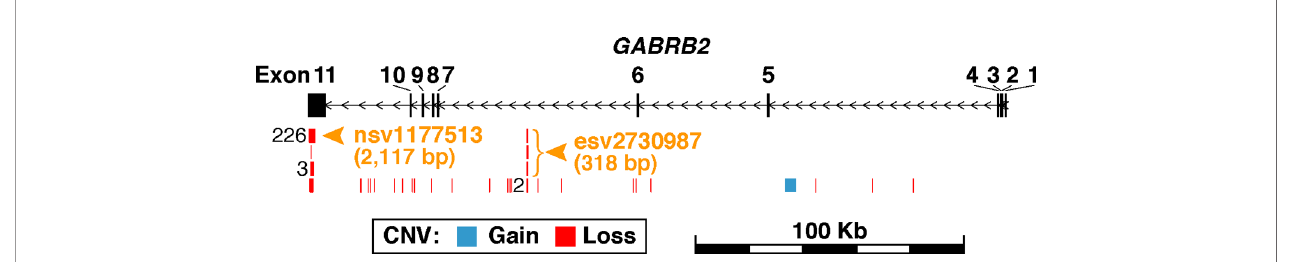
FIGURE 1 | Schematic representation of germline CNVs in GABRB2 . The region shown spans 20-Kb upstream and downstream of GABRB2 at chr5:160,715,436- 160,975,130. Exons are represented by the black vertical rectangles, and introns by horizontal line segments between the exons. Each exon is numbered above its corresponding rectangle. Black arrows indicate direction of transcription. CNVs retrieved from the database of human genomic structural variation (dbVar; fi le date 2018-03-04) are shown in blue for copy-number-gains and red for copy-number-losses. CNVs with identical genomic coordinates are merged as one in the fi gure, with their number of occurrences labeled left to their positions. A total of 261 CNVs falling within GABRB2 are mapped to 31 parental copy-number-regions in dbVar (see the full list of CNVs in Supplementary Table S1A and the summary statistics of their parental copy-number-regions in Supplementary Table S1B ). CNVs are found to be highly recurrent in Exon 11 and Intron 6, where the parental copy-number-regions with the most CNV occurrences were selected for investigation in the present study. Orange arrowheads and bracket indicate the locations of the two investigated copy-number-regions, viz. , nsv1177513 at chr5:160,715,688- 160,717,804 with identical CNVs from 226 samples, and esv2730987 at chr5:160,796,703-160,797,020 with three different CNVs from